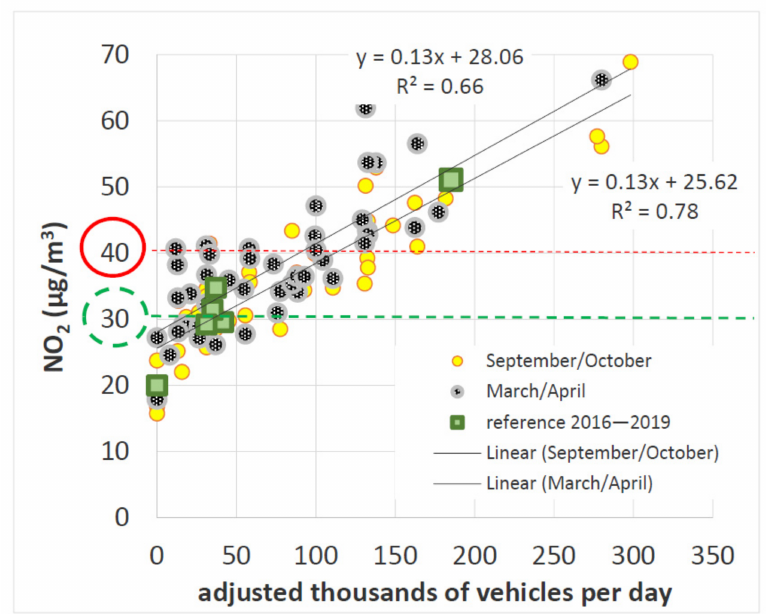
Figure 8. Relationship between adjusted traffic intensity (traffic count × (1 + fraction of vehicles travelling uphill + 3 × fraction of vehicles stopping at an intersection)) and NO 2 concentrations measured by passive samplers (average of all measurement periods) and by the national monitoring network (average of 2016–2019). EU annual limit of 40 µ g/m 3 NO 2 shown as a red line, Swiss federal limit of 30 µ g/m 3 NO 2 shown as a dotted green